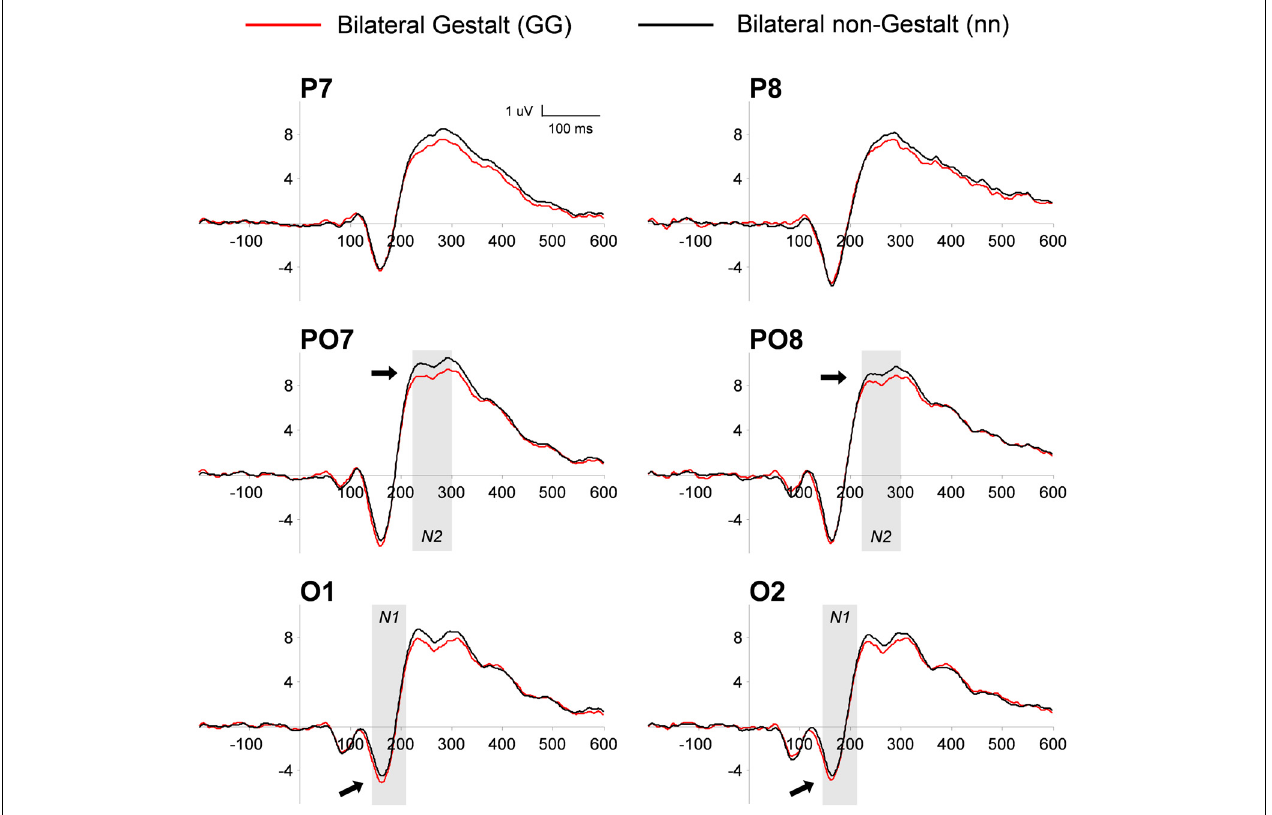
FIGURE 4 | Grand-average of PO ERP waveforms for bilateral Gestalt and non-Gestalt stimuli. Average ERP waveforms throughout the epochs (-200 to 600 ms) for bilateral Gestalt (red line) and bilateral non-Gestalt (black line) stimuli at occipital (O), PO, and parietal (P) electrodes on both hemispheres. Arrows indicate significant effects on N1 and N2 components and the shaded gray areas indicate time-windows in which significant effects were